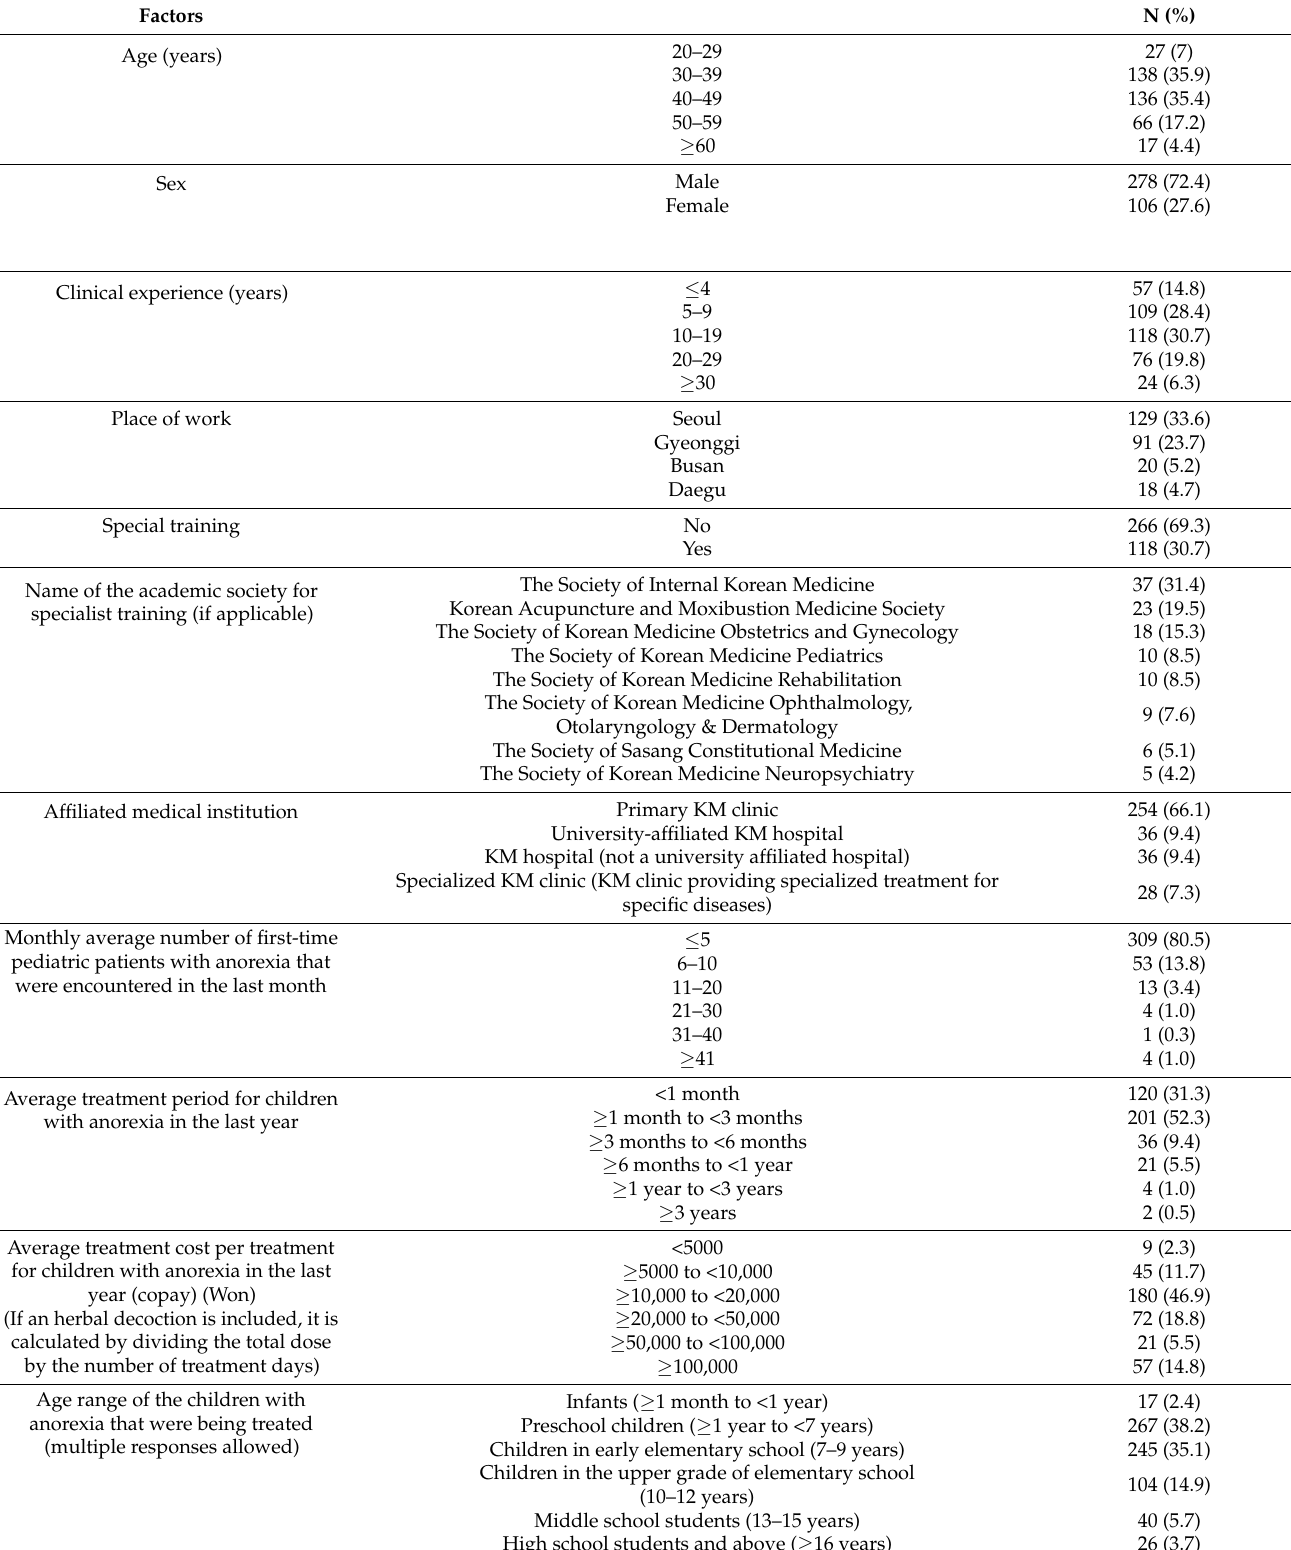
Table 1. Sociodemographic characteristics of the surveyed Korean medicine doctors (N =